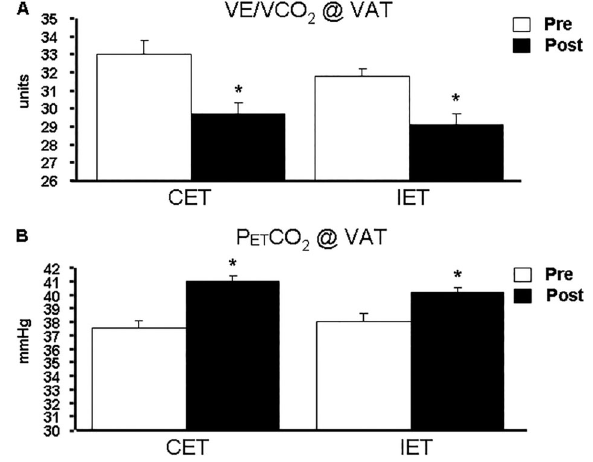
Figure 5. Effects of continuous exercise (CET) and interval exercise training (IET) on indices of ventilatory ef fi ciency in coronary artery disease patients. Panel A , Ventilation to carbon dioxide production relationship (VE/VCO 2 ) at ventilatory anaero- bic threshold (VAT); Panel B , End-tidal CO 2 pressure (P ET CO 2 ) at VAT. Pre: pre-intervention; Post: post-intervention. *P o 0.05 vs pre-intervention. Adapted from reference